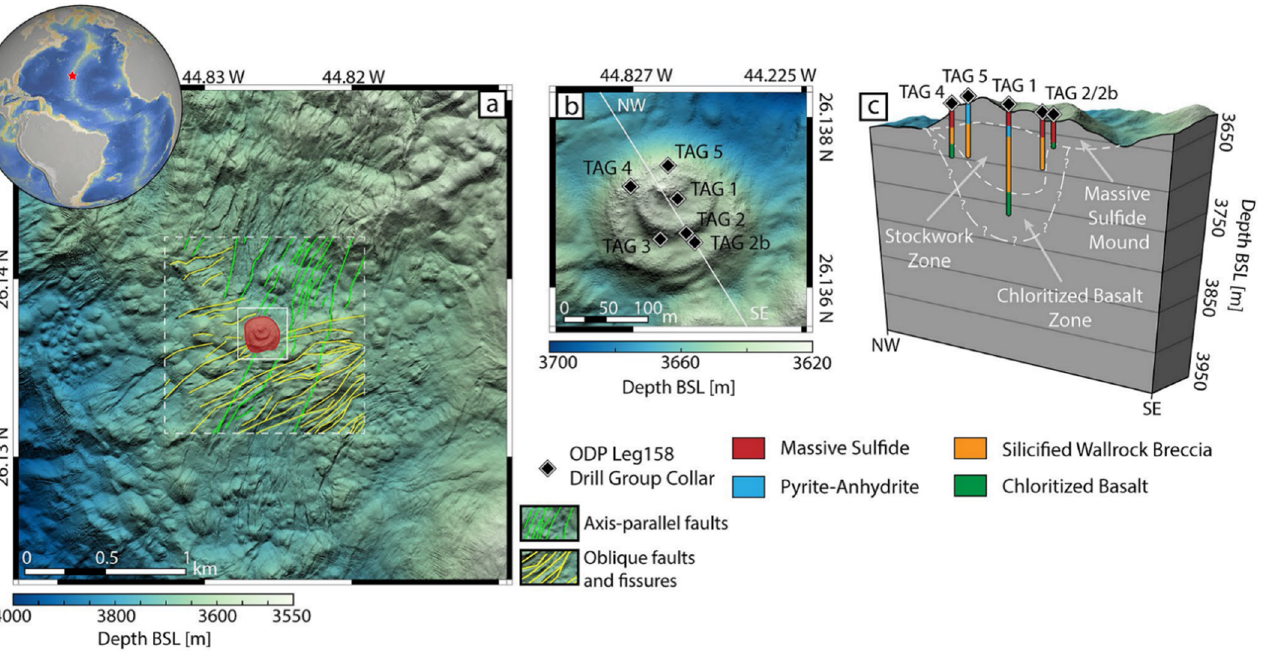
Figure 2. The active TAG hydrothermal field [31].